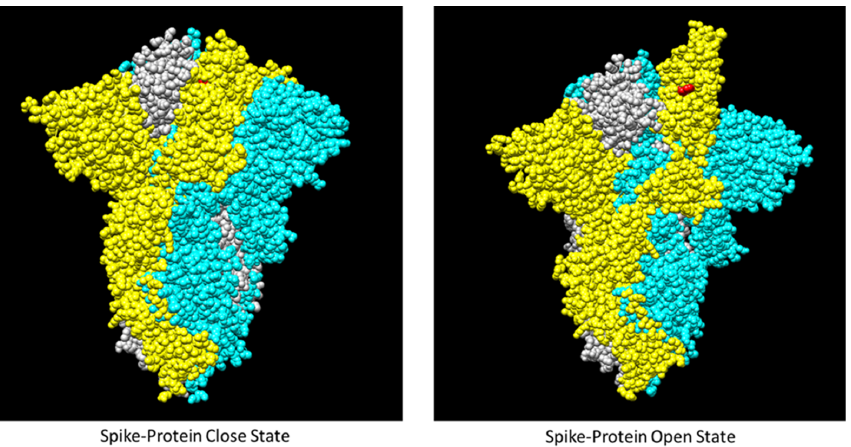
Figure 6. Interaction between the SARS-CoV-2 spike RBD (white) and ACE2 (cornflower blue) as shown by the crystal structure of the RBD/ACE2 complex. The amino acid W436 is labeled in red, whereas the point mutations of the Delta variant (K417N, L452R, E484K, and T478K) are labeled in green.